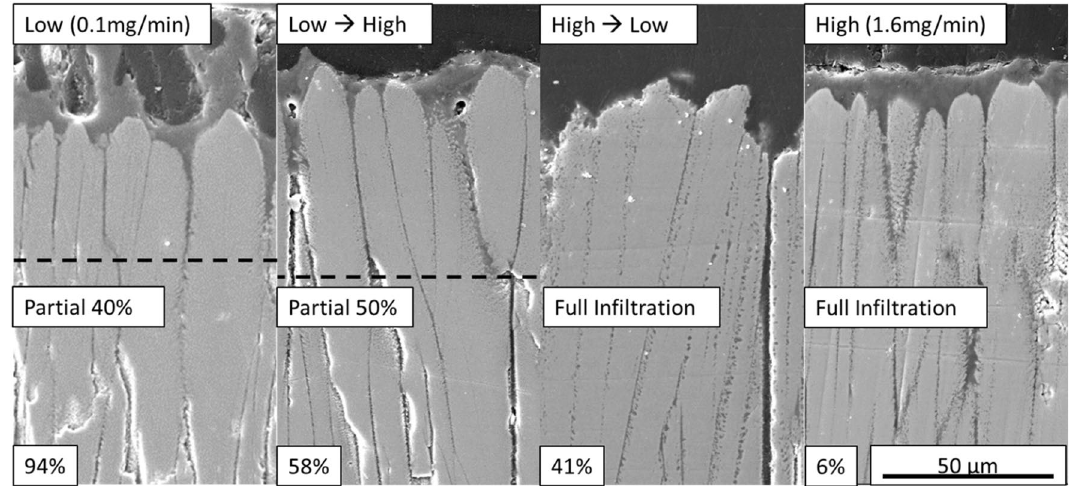
Fig. 9 CMAS infiltration depths of Low, Low to High, High to Low, and High deposition rate conditions. Labels from top to bottom are depo- sition condition, infiltration depth, and normalized lifetime,